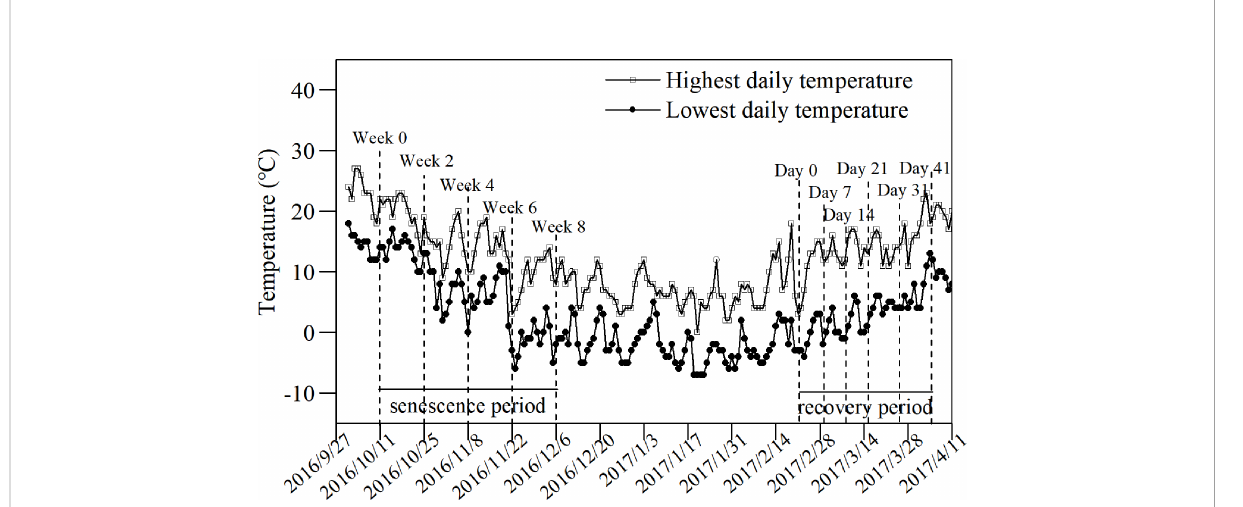
FIGURE 1 Changes in daily temperatures during the decline and revival stages of L. japonica . Lines with blank squares and fi lled circles indicate the highest and lowest daily temperatures, respectively. The dashed lines indicate the sampling